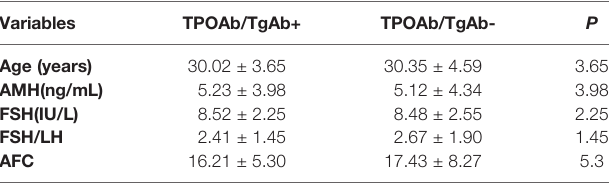
TABLE 5 | Comparison of TPOAb/TgAb + and TPOAb/TgAb-. Variables TPOAb/TgAb+